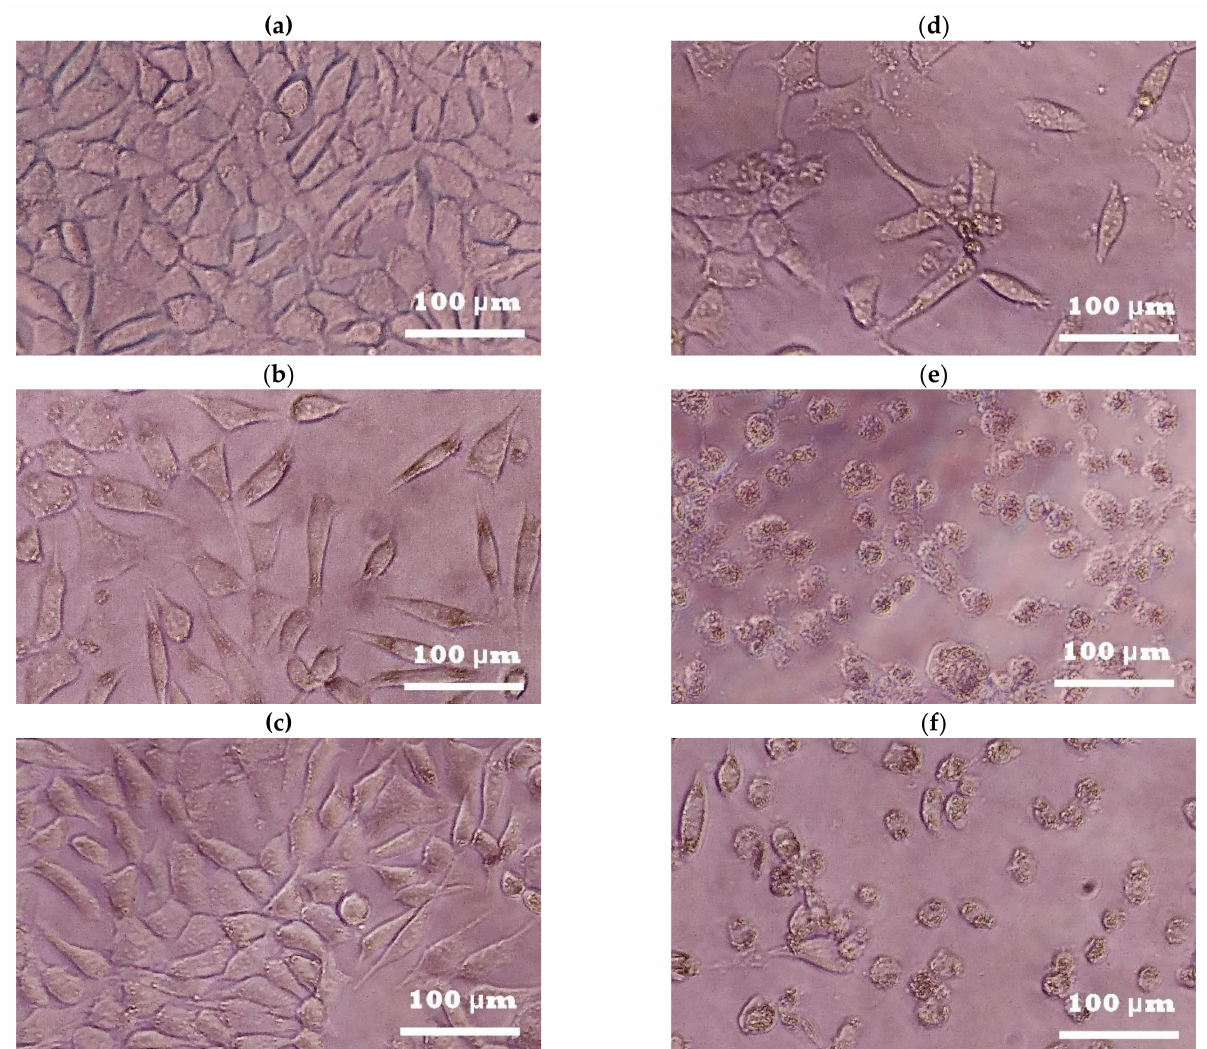
Figure 2. Changes in 3T3-Swiss albino fibroblast cell morphology during photoprotection and cytotoxicity assays: ( a ) without any treatment, ( b ) with extract (1250 µ g/mL) and UVB irradiation (293 mJ/cm 2 , corresponding to 25 min of UVB exposure), ( c ) with extract (1250 µ g/mL) at 25 min and 24 h exposure without UVB irradiation, ( d ) with UVB irradiation (293 mJ/cm 2 ; corresponding to 25 min of UVB exposure), ( e ) non-UVB-irradiated cells supplied with cytotoxic concentrations of extract (2500 µ g/mL; 25 min and 24 h of exposure), and ( f ) non-UVB-irradiated cells supplied with cytotoxic concentrations of verbascoside (>250 µ g/mL; 25 min of exposure). The micrographs are from inverted microscopy using a 20 × objective prior to measuring cell viability using the 3-[4,5-dimethylthiazol-2-yl]-2,5-diphenyltetrazole bromide (MTT)